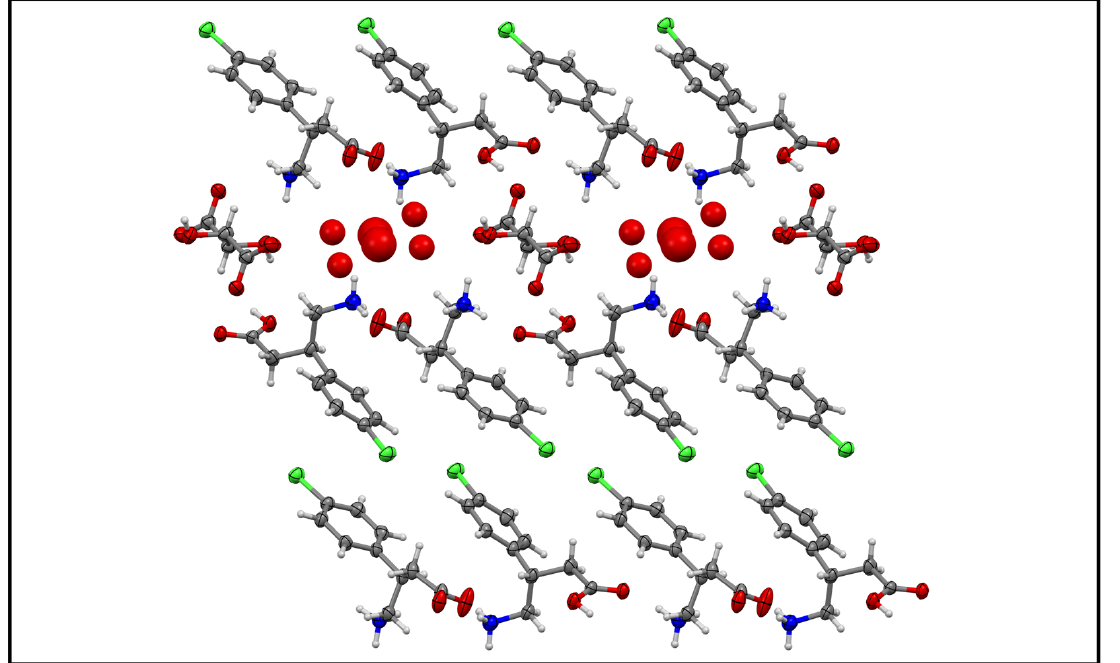
Figure 5 . Crystal packing of Baclofen: D − malic acid • H 2 O; view from a-axis. Strongly disordered water molecules accumulate in the pores between Baclofen and malic acid entities. Both malic acid molecules are half occupied and invert their alignment at each position. Carbon atoms are depicted in grey, hydrogen atoms are white, oxygen atoms are red, nitrogen atoms are blue and chlorine atoms are green.